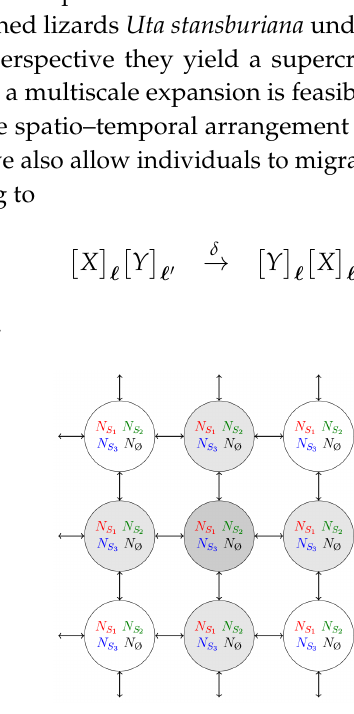
Figure 1. (Color online). Cartoon of the metapopulation model: L × L patches (or islands) are arranged on a periodic square lattice (of linear size L ). Each patch (cid:96) = ( (cid:96) 1 , (cid:96) 2 ) can accommodate at most N individuals of species S 1 , S 2 , S 3 and empty spaces denoted ∅ . Each patch consists of a well–mixed population of N S individuals of species S 1 , N S of type S 2 , N S of type S 3 and 2 3 1 − N − N N ∅ = N − N S S 2 S 3 empty spaces. The composition of a patch evolves in time according 1 to the processes (1) and (2). Furthermore, migration from the focal patch (dark gray) to its four nearest–neighbors (light gray) occurs according to the process (3), see text. Adapted from